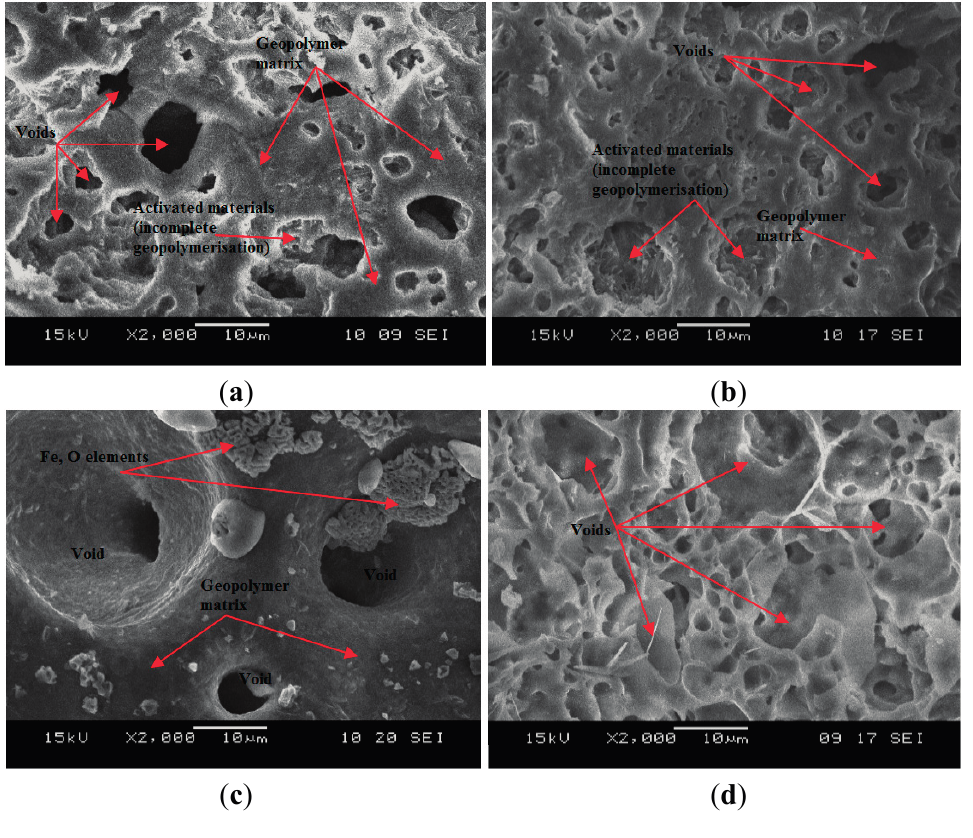
Figure 7. SEM micrograph of ALGA produced at ( a ) LM/AA = 1.7 and Na 2 SiO 3 /NaOH = 0.4; ( b ) LM/AA = 1.8 and Na 2 SiO 3 /NaOH = 0.4; ( c ) LM/AA = 1.9 and Na 2 SiO 3 /NaOH = 0.4; ( d ) control